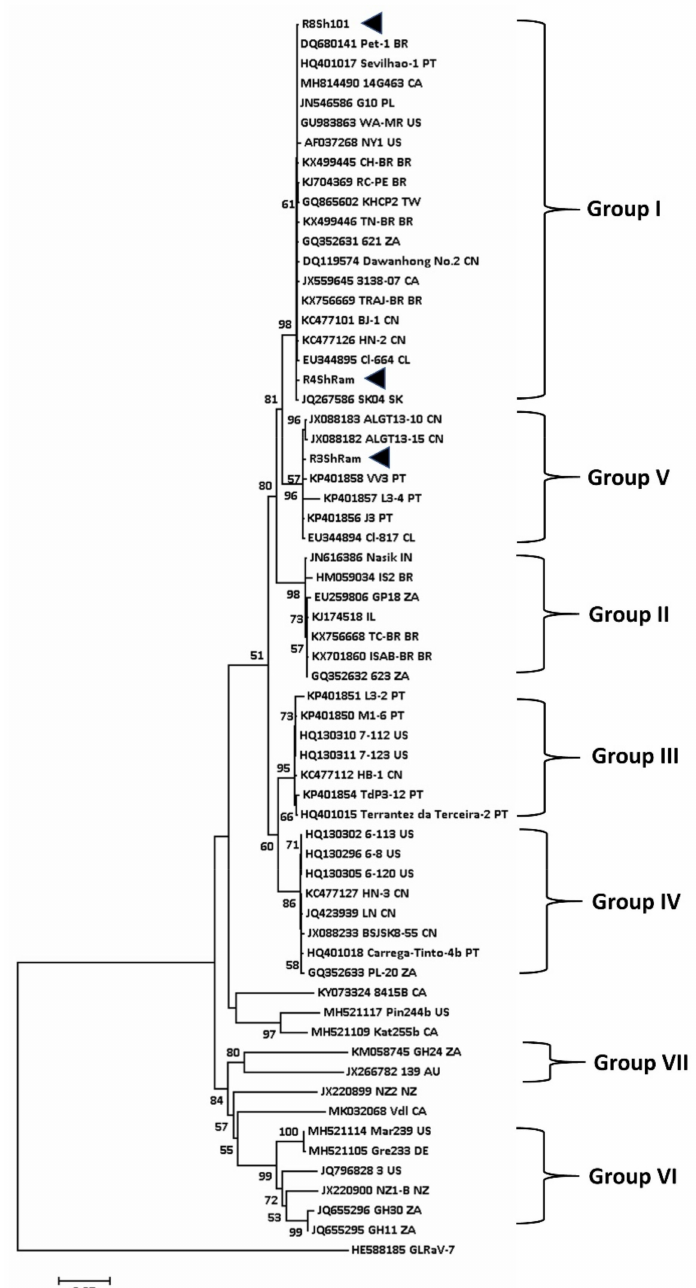
Figure 4. Phylogenetic tree constructed from the alignment of full-length nucleotide sequence of the coat protein of various isolates of GLRaV-3 (see also [73]) detected in the grapevine using Mega 7. A total of 1000 bootstrap replications were performed using neighbour-joining method. Bootstrap values less than 50% are not shown. Arrowheads denote the Australian isolates studied in this work. GLRaV-7 (HE588185) presents outgroup of this